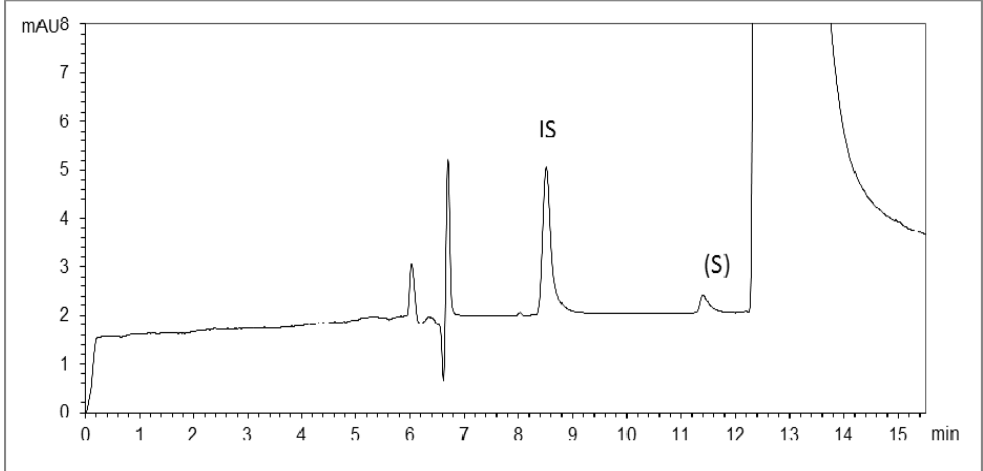
Figure 7. Armodafinil standard (5 mg/mL) containing 0.1% ( S )-modafinil. Other conditions are as in Figure